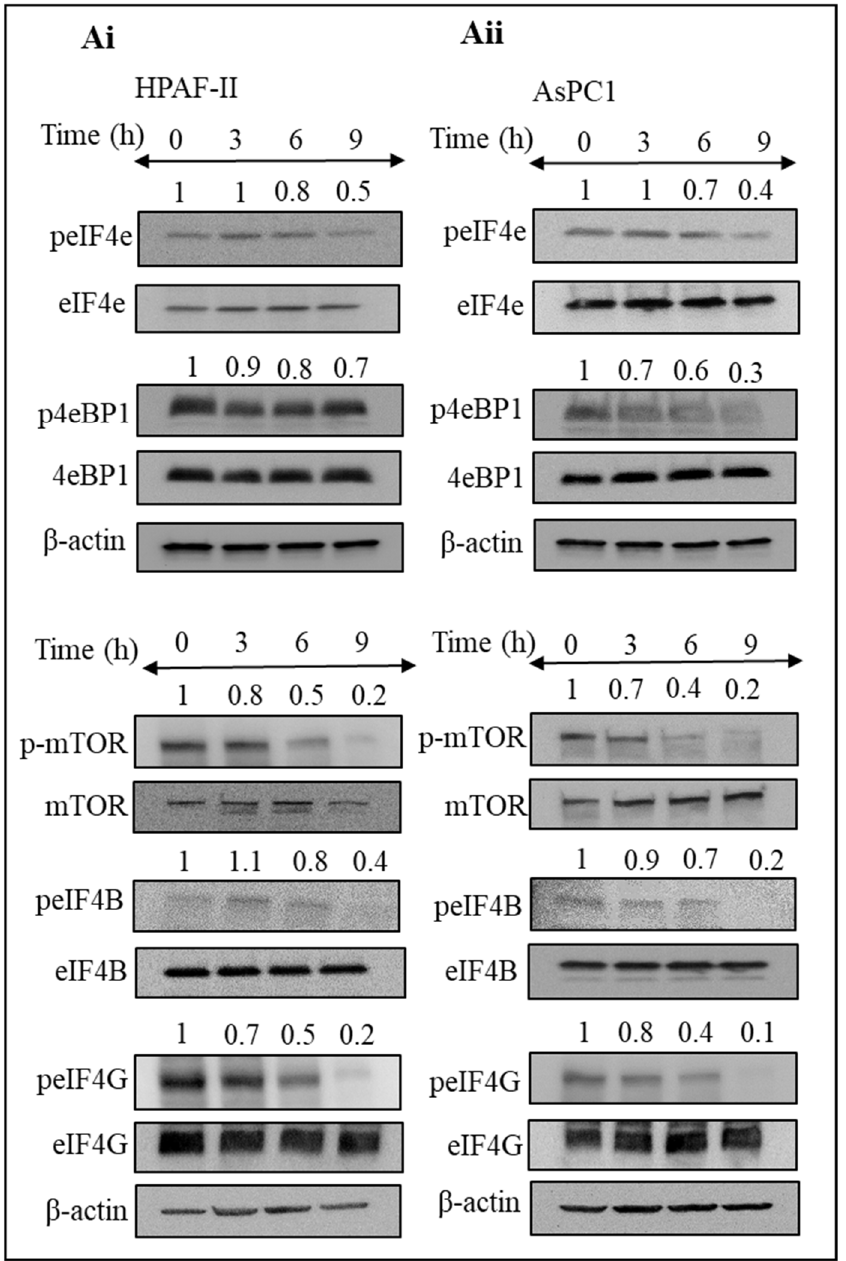
Figure 5. Steviol impedes translation initiation in pancreatic cancer cells. ( A ) Western blotting was performed to analyze the expression level of proteins associated with translation initiation in pancreatic cancer HPAF-II ( Ai ) and AsPC1 cells ( Aii ). Cells were treated with steviol (10 mM) at different time intervals (0, 3, 6, and 9 h), and whole cell lysates were prepared. The numbers above the blots represent the relative band intensity after normalizing with β -actin.